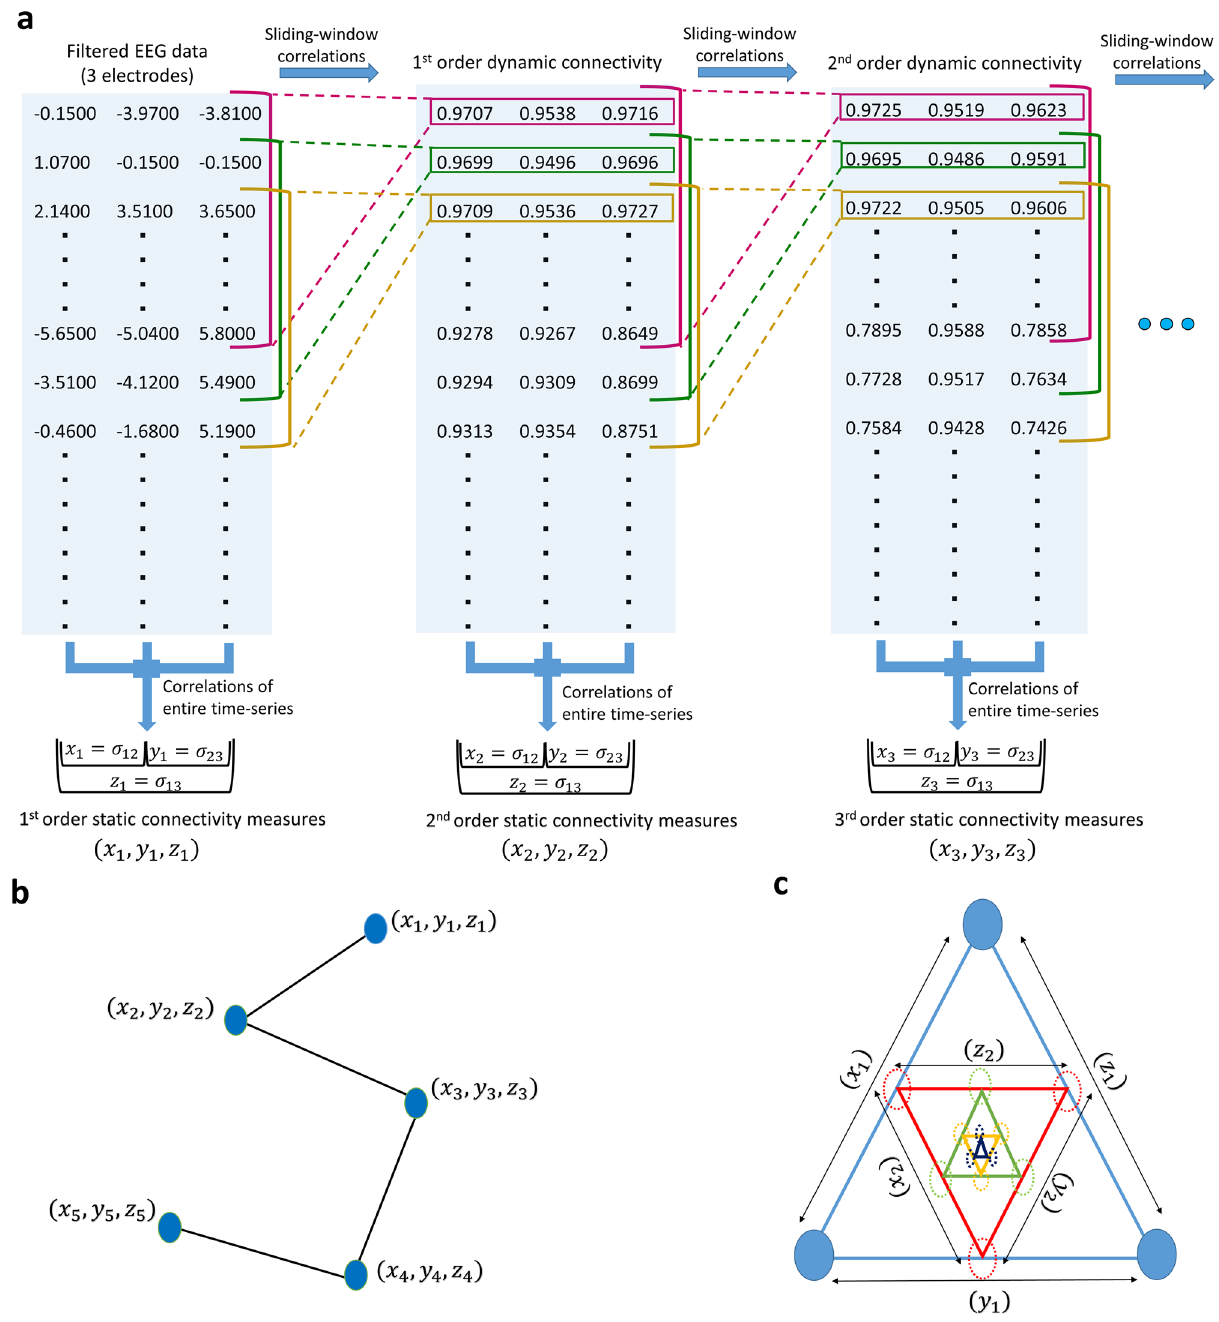
Figure 1. Computation of recursive dynamic functional connectivity of a triplet of electrodes. ( a ) The band-pass filtered EEG data of a set of three electrodes is processed using a sliding window to generate the 1st order dynamic connectivity time-series. The same sliding window is applied again on the 1st order dynamic connectivity time-series just obtained to produce the 2nd order dynamic connectivity time-series. The process of recursively applying the sliding window is carried out until the 4th order dynamic connectivity time-series is obtained, which is also the 5th set of time-series when including the original EEG data. In the second step, each of the five sets of time-series are summarized by taking correlation coefficients over their entire duration to compute three static connectivity measures at each order. ( b ) The three static connectivity measures computed at each order are then assigned to a coordinate value of a three dimensional point representing that order. Finally, all the five points corresponding to the five sets of trivariate time-series are connected with line segments to give a 5-point recursive dynamic connectivity pattern in a 3-dimensional space. ( c ) The multi-order connectivity of a triplet of electrodes can also be viewed as a hierarchical graph. Each triangle represents a particular order with the edges of the triangle representing the static connectivity measures. For the first order (outermost triangle) the nodes are the three electrodes used for rdFC analysis. The dynamic connectivity of these electrodes is seen as activity of pseudo nodes (dotted circles) that are connected by second order static connectivity measures. As we traverse inwards subsequent higher order static connectivity is represented as edges that connect their respective higher order pseudo